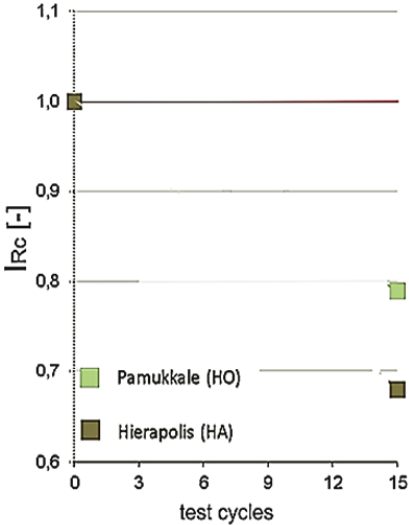
Fig. 11. Strength reduction index I Rc after the impact of salt